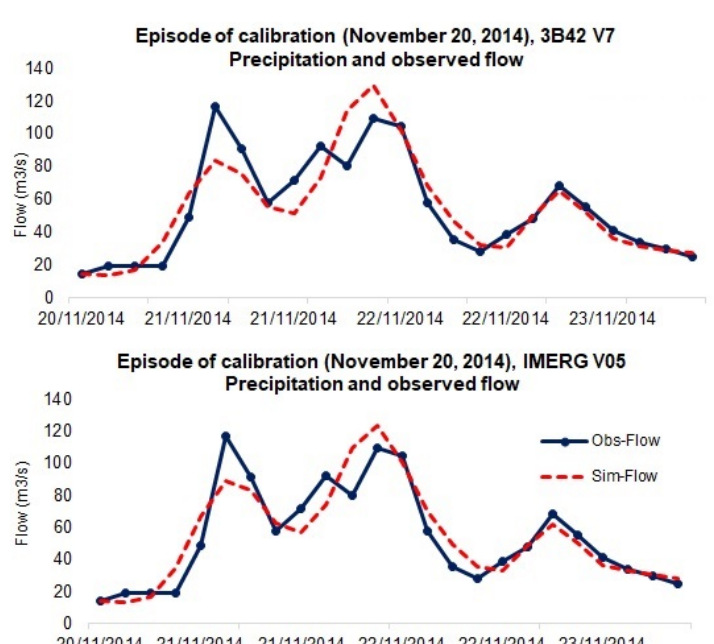
Figure 2. Calibration of the episode 20 November 2014, using 3B42V7 and IMERG V05 rainfall products and observed runoff data as input.